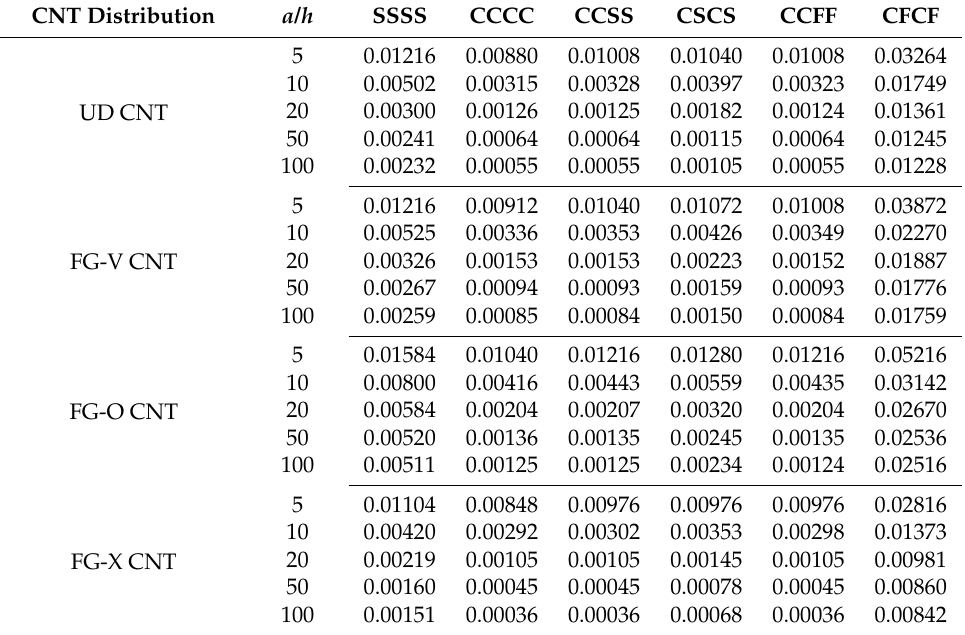
Table 11. Central transverse deflection of an FG-CNT-reinforced square plate subjected to sin-sin = 0.11. loading V ∗ CNT